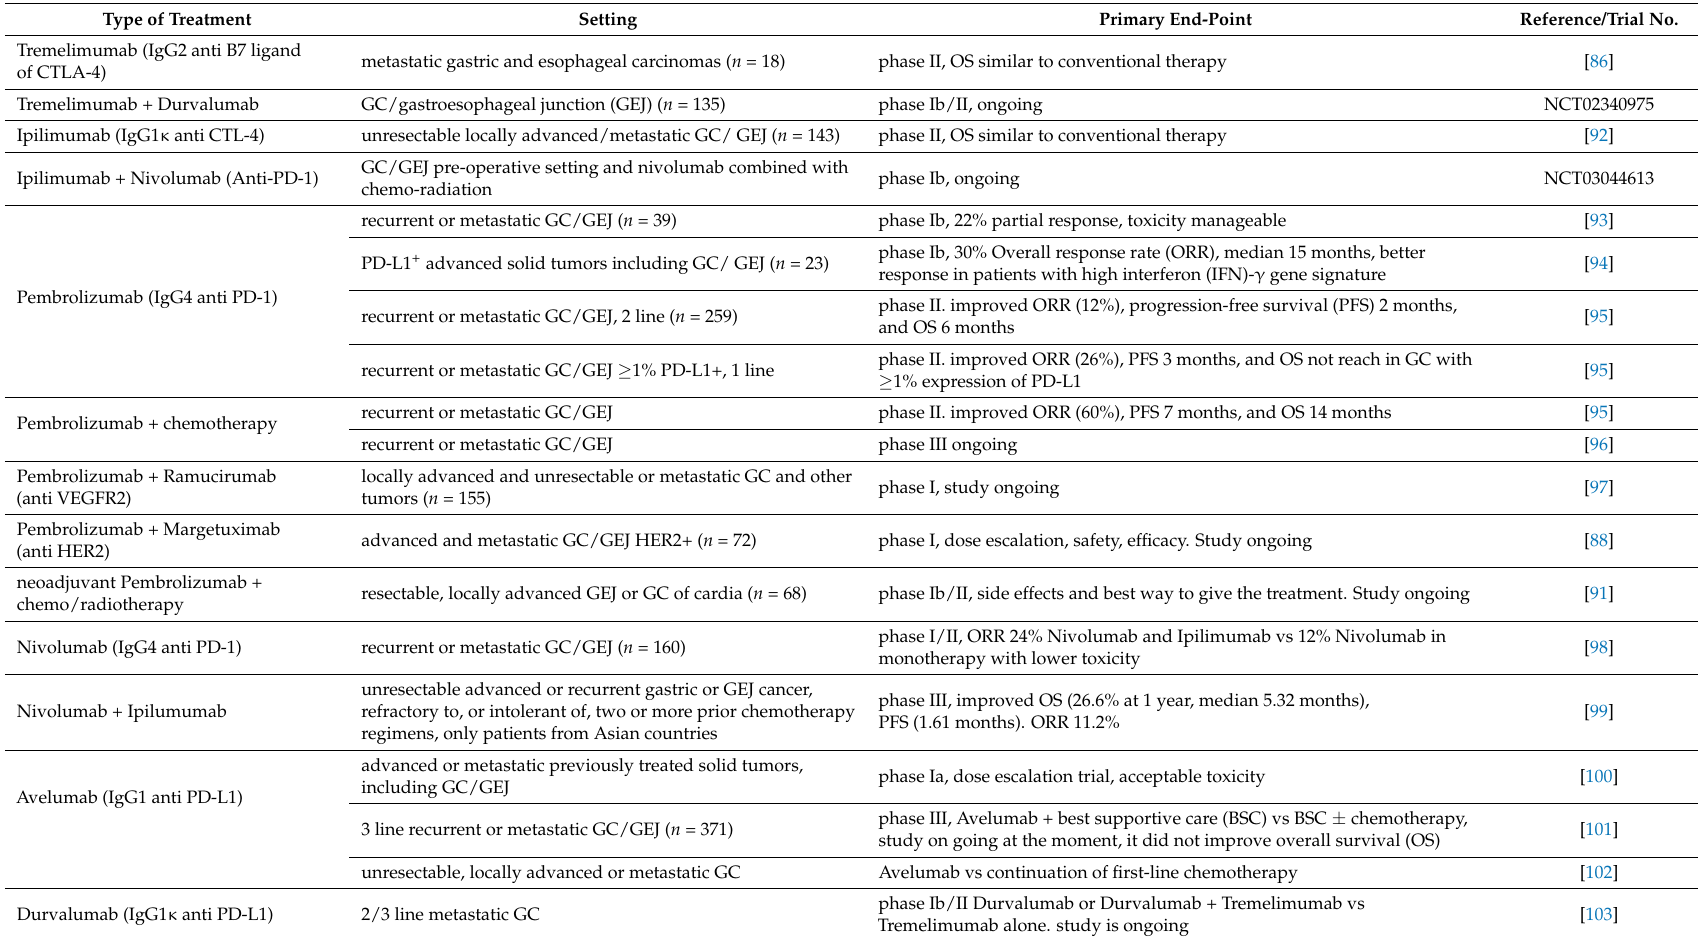
Table 4. Immune checkpoint